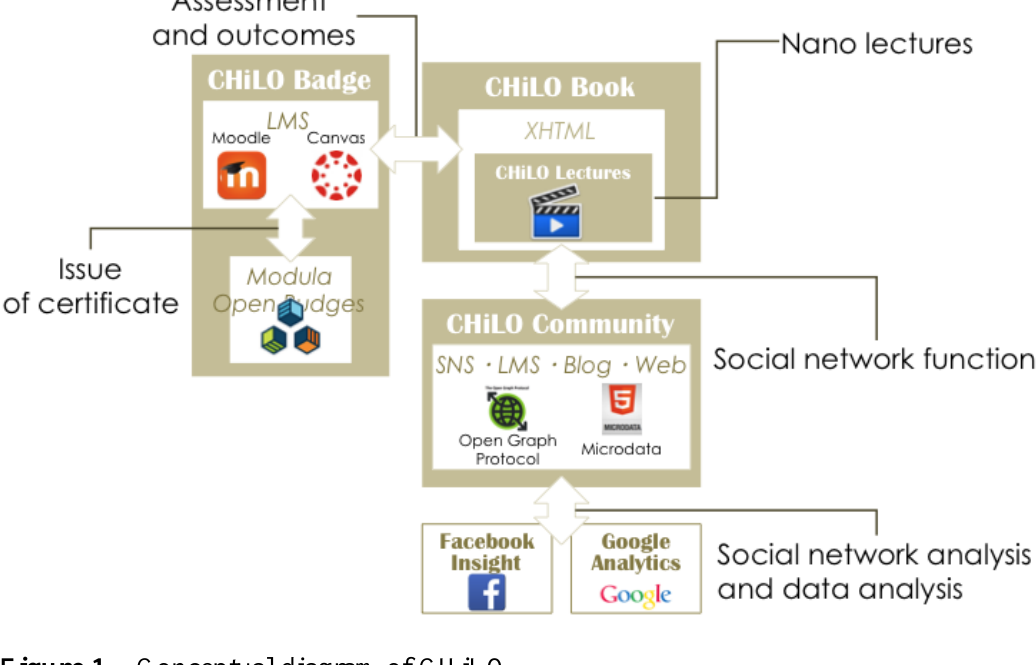
Figure 1 Conceptual diagram of